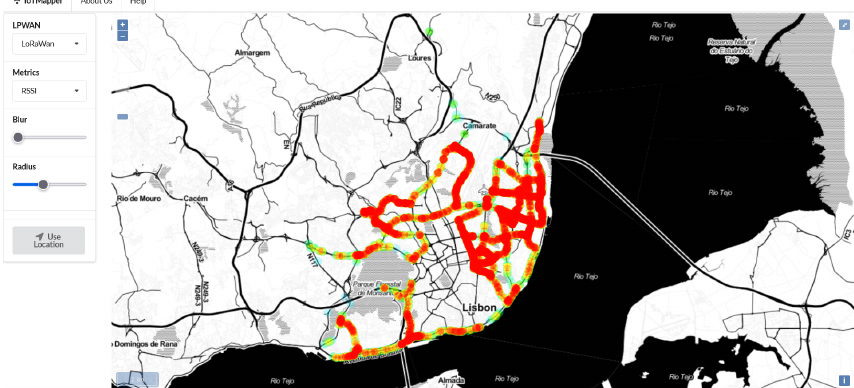
Figure 5. User interface developed for the IoTMapper system. Displaying relative RSSI levels for LoRaWAN in